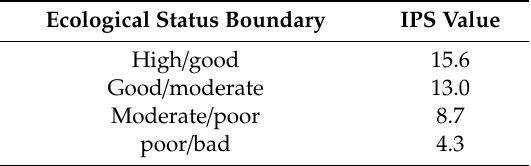
Table 3. Boundary values of ecological states for hydromorphological type 23, based on IPS [64].